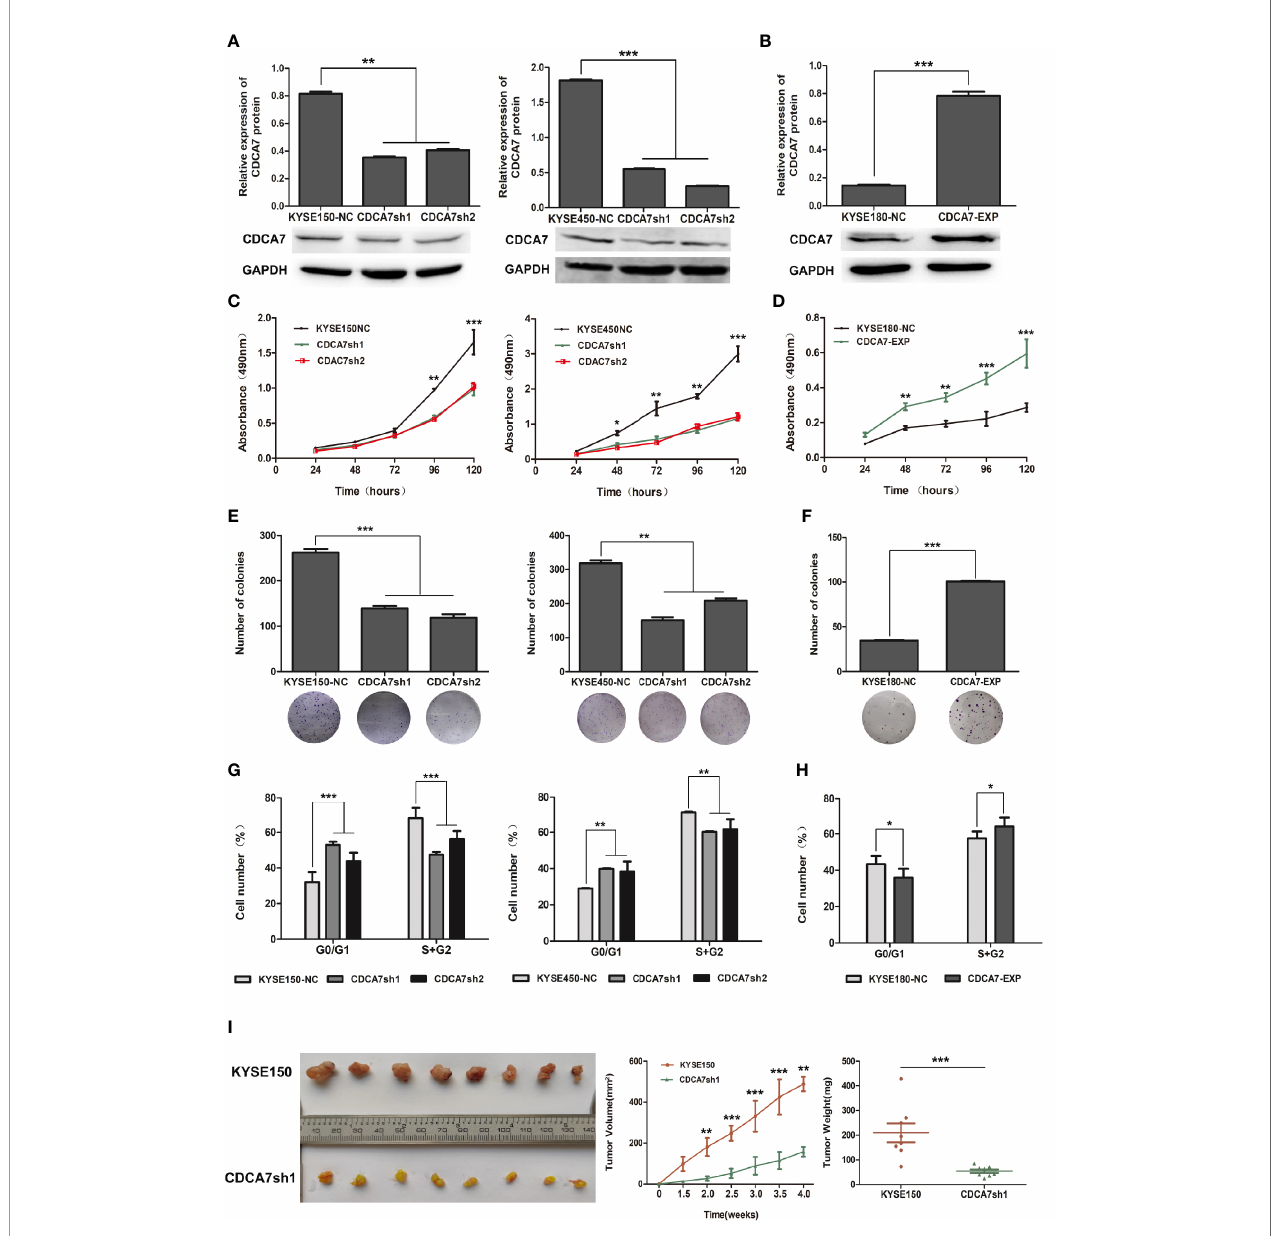
FIGURE 2 | The effect of CDCA7 gene in ESCC cell lines. (A) The CDCA7 knockdown ef fi ciency in KYSE150 and KYSE450 cells. (B) The CDCA7 overexpression ef fi ciency in KYSE180 cells. (C) CDCA7 knockdown inhibited the proliferation of ESCC Cells. (D) CDCA7 overexpression promoted the proliferation of ESCC cells. (E) CDCA7 knockdown inhibited the ability of colony formation in ESCC cells. (F) CDCA7 overexpression promoted the ability of colony formation in ESCC cells. (G) CDCA7 knockdown inhibited the cell cycle of ESCC cells. (H) CDCA7 overexpression promoted the cell cycle of ESCC cells. (I) Tumor growth was inhibited signi fi cantly in the CDCA7-knockdown group compared with the control group in vivo. Left: tumor tissues in the CDCA7-knockdown group and the control group; right: tumor weight and tumor growth curve. (0.01 < P ≤ 0.05, *; 0.001 < P ≤ 0.01, **; P ≤